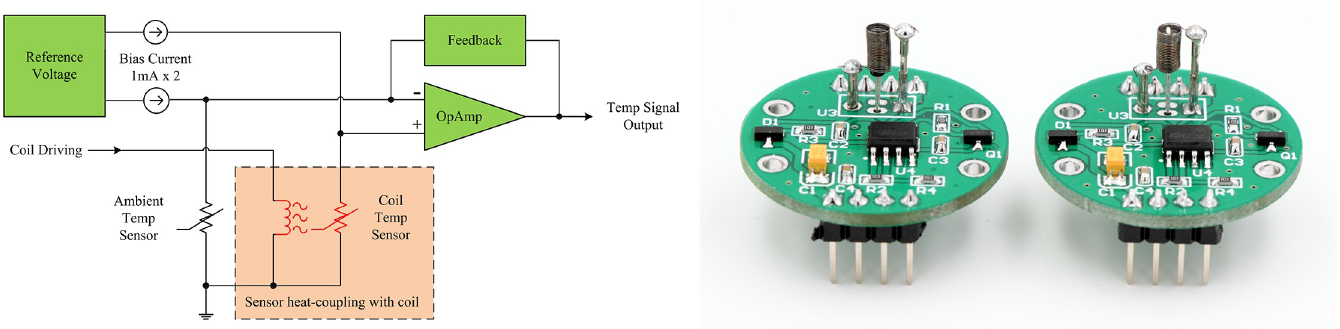
Fig 2. Wind velocity sensor. (A) Block diagram and (B) photograph of the